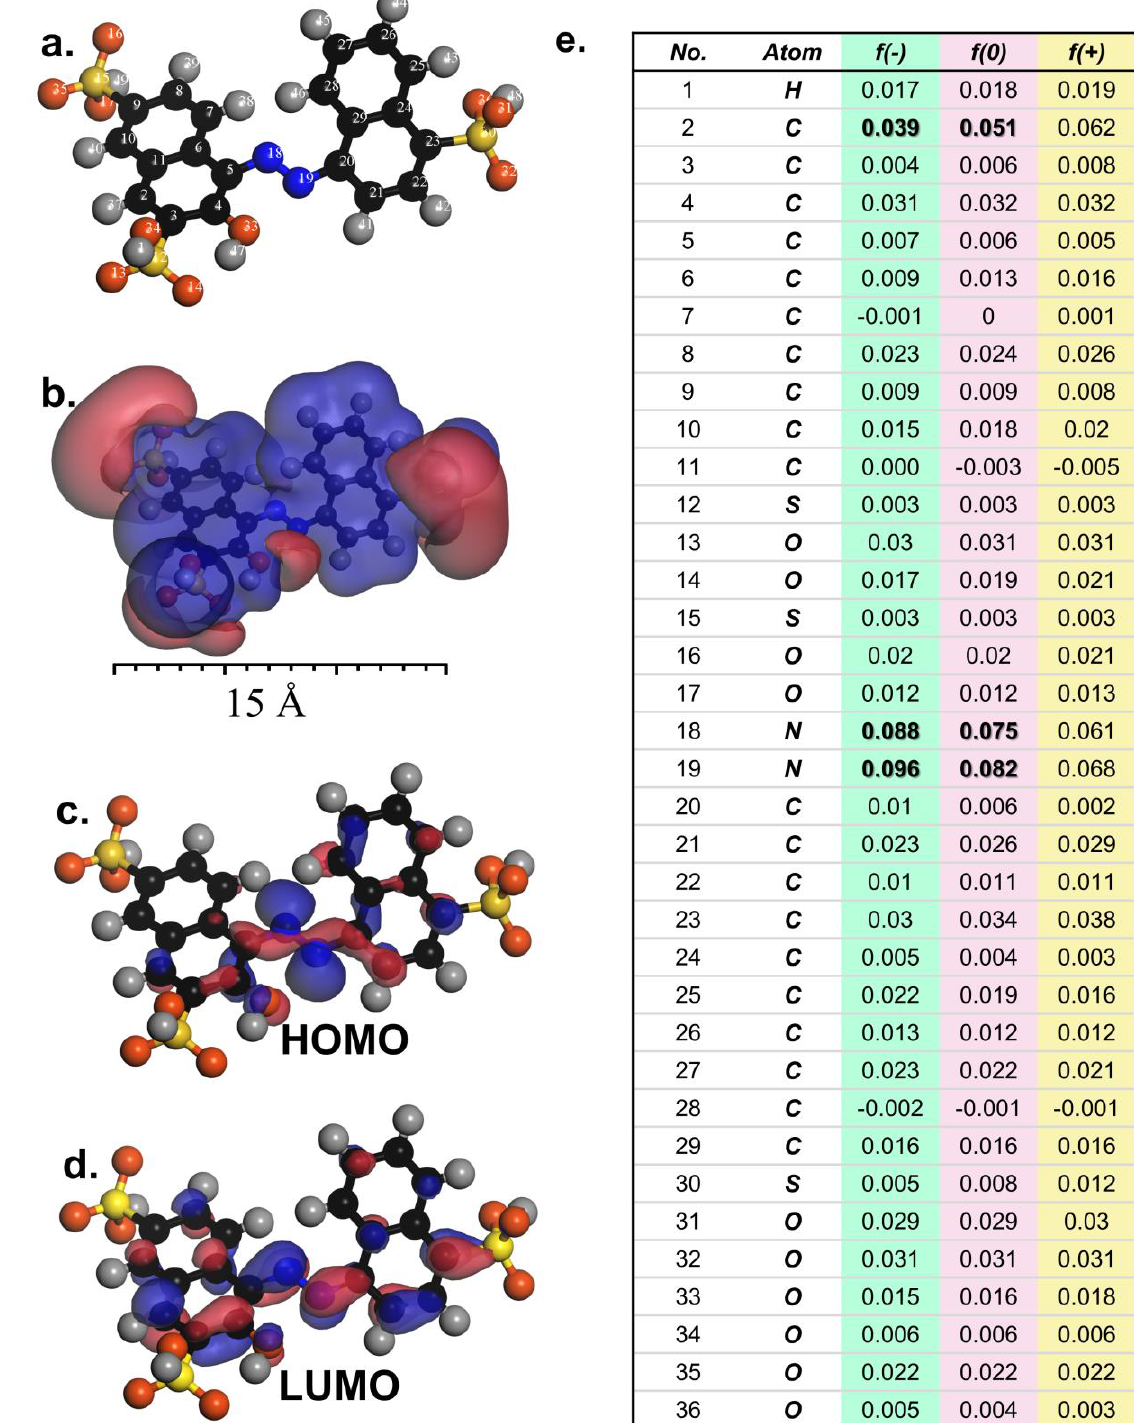
Figure 9. DFT calculation for AR: ( a ) the optimized molecule structure; ( b ) electrostatic potential (ESP); ( c ) HOMO; ( d ) LUMO; and ( e ) condensed Fukui index distribution for electrophilic attack (f – ), radical attack (f 0 ), and nucleophilic attack (f + ).